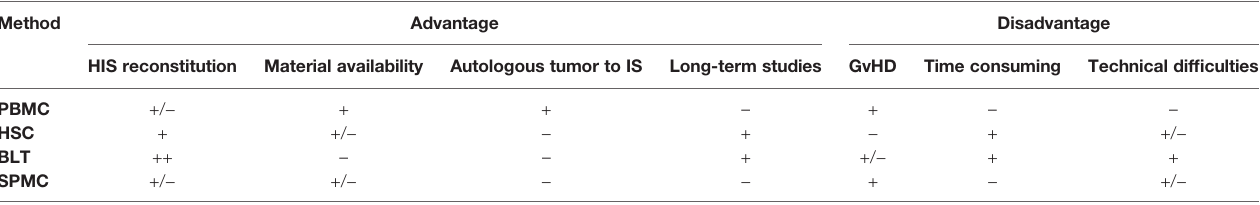
TABLE 1 | Comparison of the methods used to generate humanized